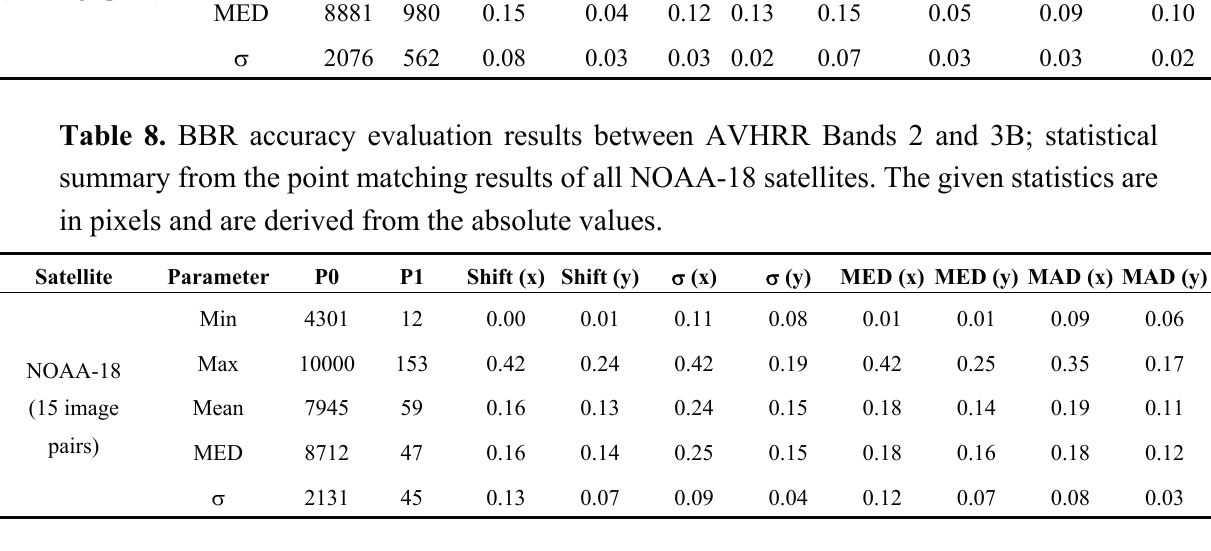
Table 9. BBR accuracy evaluation results between AVHRR Bands 2 and 4; statistical summary from the point matching results of all images for the three satellites. The given statistics are in pixels and are derived from the absolute